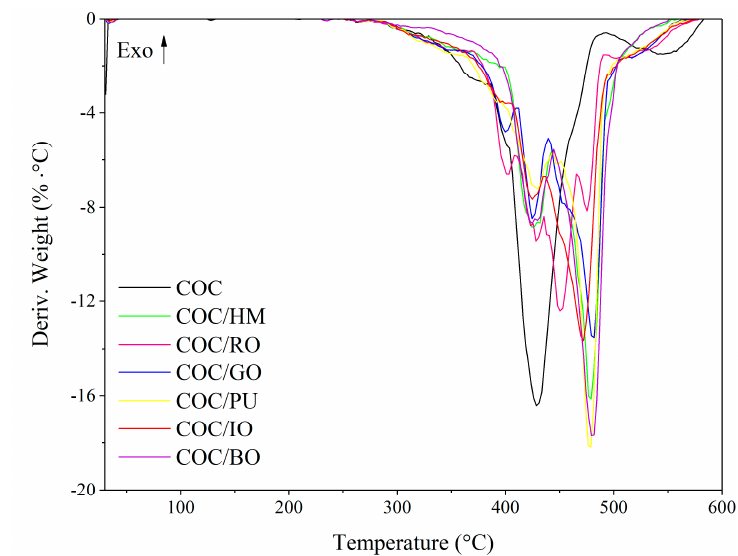
Figure A2. Derivate thermogravimetric (DTG) curves obtained for COC composites filled with different earth pigments measured in an air atmosphere.